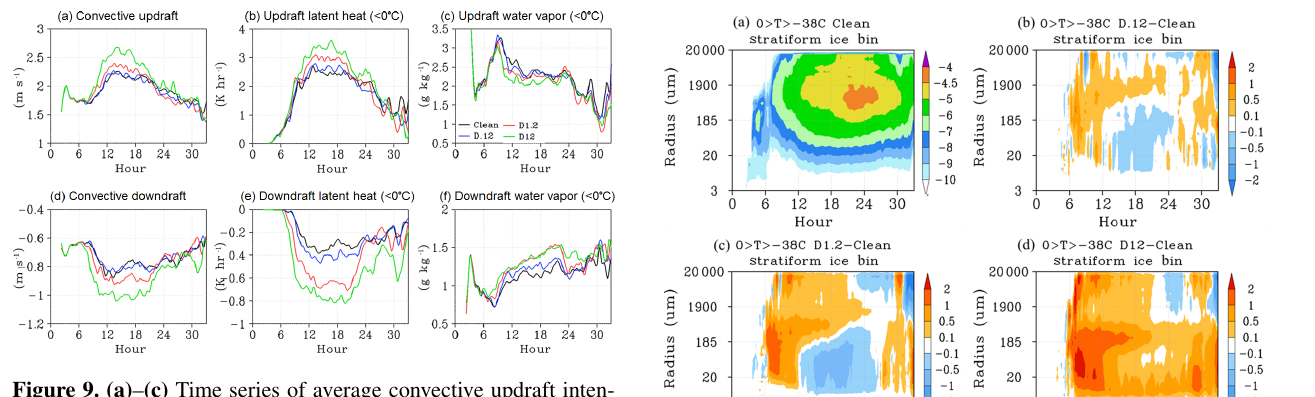
Figure 9. (a) – (c) Time series of average convective updraft inten- sity. Time series of average latent heat (Khr − 1 ) within convec- tive updrafts (<0 ◦ C). Time series of average water vapor content (gkg − 1 ) within convective updrafts (<0 ◦ C). (d) – (f) As (a–c) , av- eraged over convective downdrafts. Colors represent Clean (black), D.12 (blue), D1.2 (red), and D12 (green) cases, respectively.